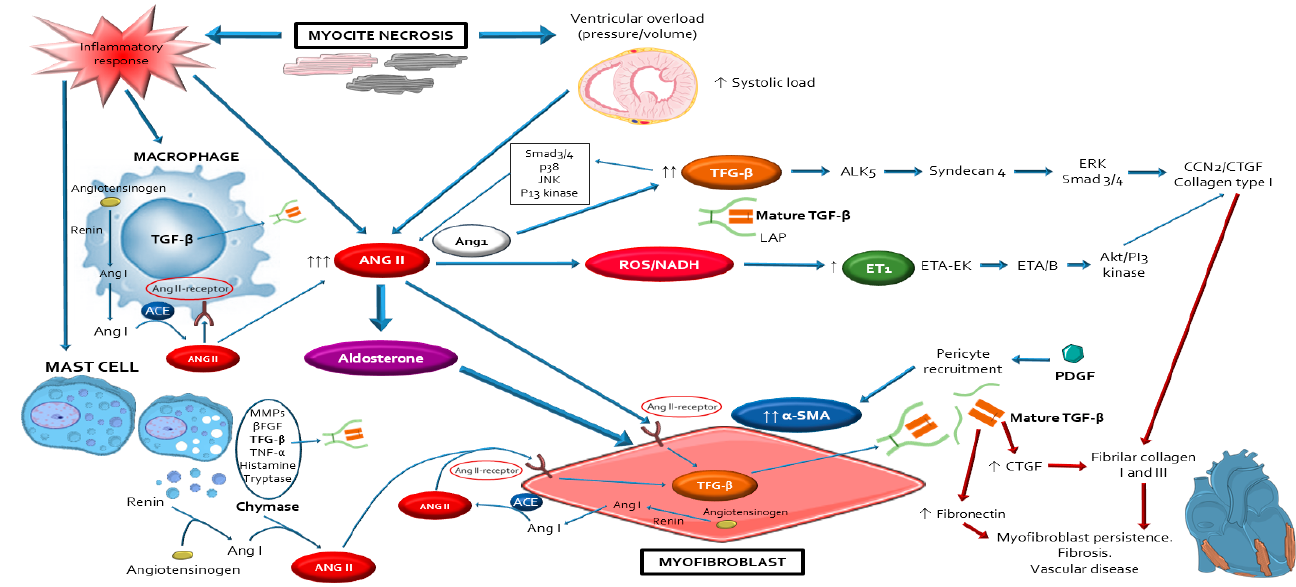
Figure 2. Schematic representation of the complex network of interplayed cellular and molecular mechanisms that participle in the development of myocardial fibrosis leading to the occurrence of dystrophin-deficient cardiomyopathy. Notice that angiotensin 2 with its type 1 receptor, have a central role modulating the activation of most of these pathways through its autocrine/paracrine actions, mostly via the TFG- β pathway. AngioTable 2. is also essential in order to maintain and perpetuate the profibrotic response, providing a source for a positive auto-feedback. Abbreviations: ACE: angiotensin-converting-enzyme; Akt: protein kinase B; ALK5: activin receptor-like kinase-1; Ang I: angiotensin I; ANG II: angiotensin II; CCN2/CTGF: connective tissue growth factor; ET1: endothelin-1; ETA: endothelin receptor A; JNK: Jun N-Terminal Kinase; LAP: latency-associated peptides; MMPs: matrix metalloproteinases; NADH: reduced nicotinamide adenine dinucleotide; PDGF: platelet derived growth factor; PI3: phosphoinositide 3; ROS: reactive oxygen species; Smad3/4: mothers against decapentaplegic homolog 3 ; TFG- β : transforming growth factor-beta; TNF- α : tumour necrosis factor alpha; α -SMA: 4 alpha-smooth muscle actin; β FGF: basic fibroblast growth factor the severity of DDC at older ages and ANG2/AT1R blockade reduces oxidative stress and fibrosis and improved improves autonomic function and cardiac functionality in dystrophic mice